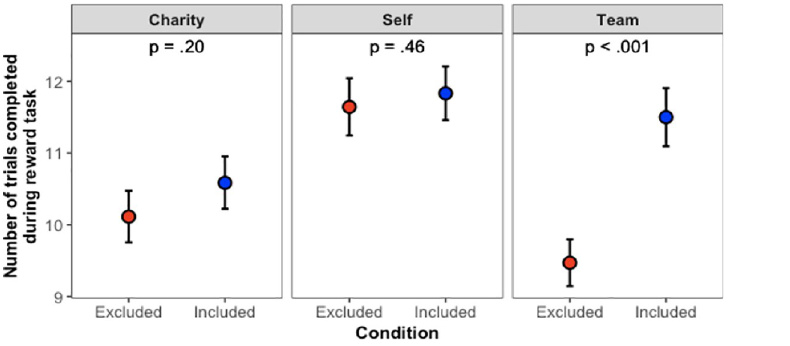
Fig 5. Main results from Study 3. Error bars show ± 1